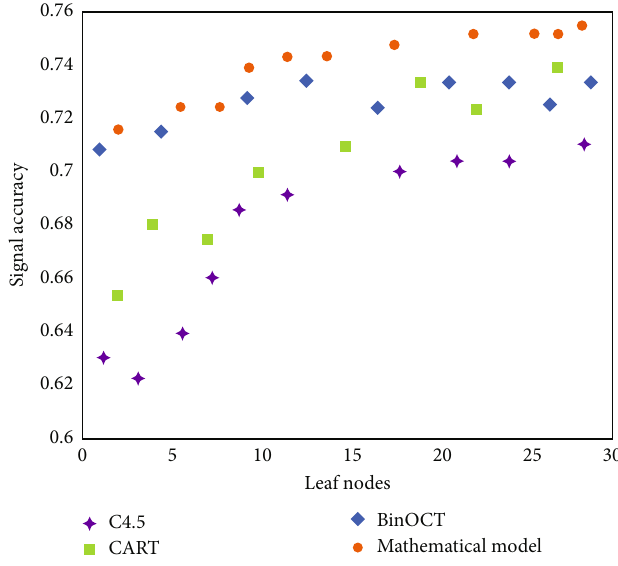
Figure 4: Comparison of signal transmission accuracy with three common mathematical